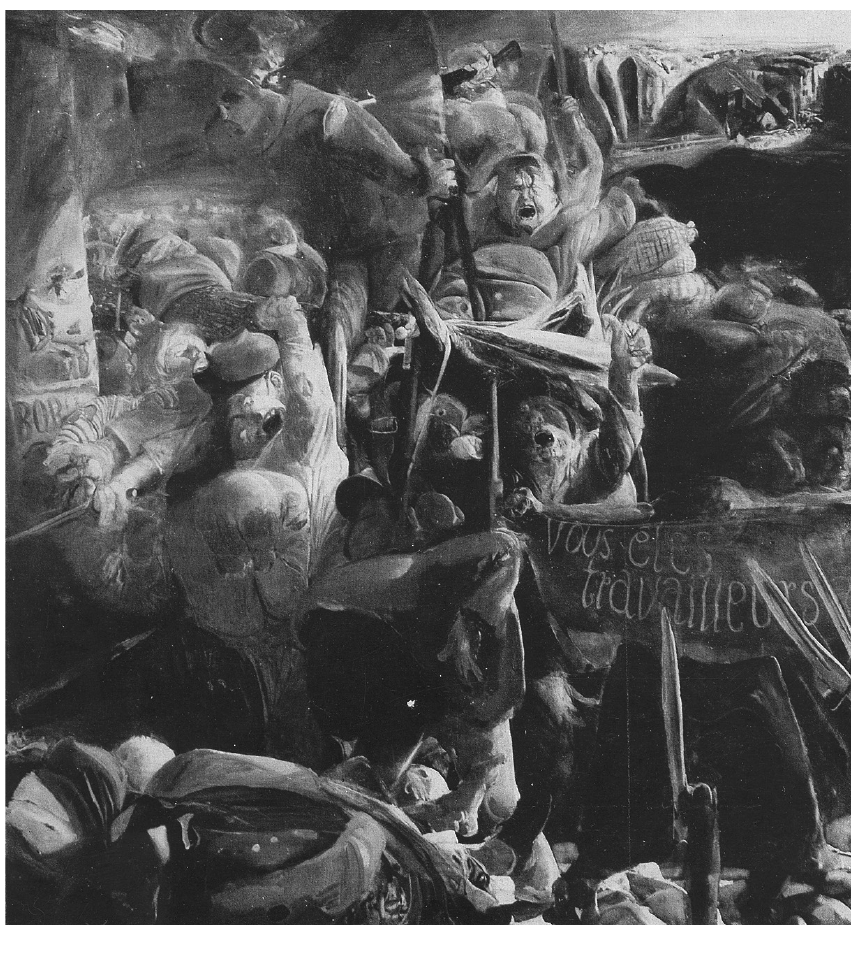
Bernhard Heisig, The Paris Commune , 1964. Oil on Canvas. 150 x 152. Destroyed through